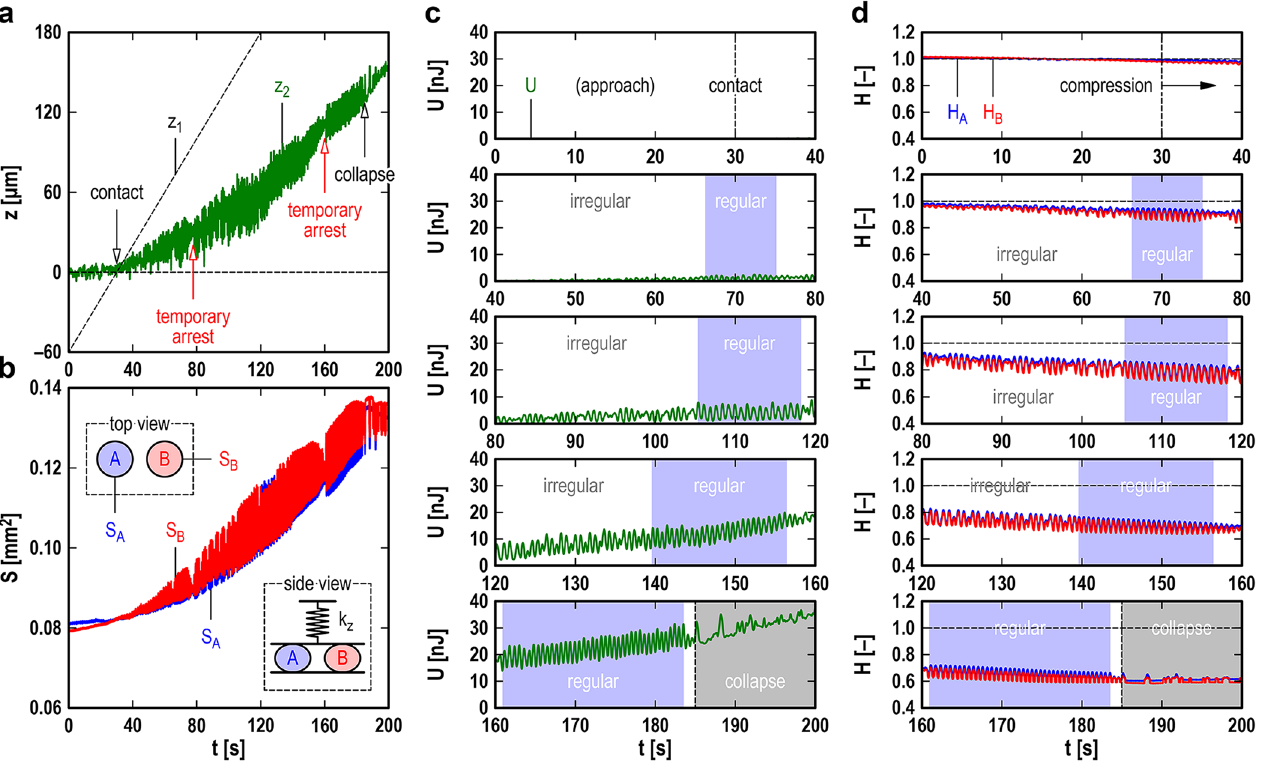
Figure 4. The mechanical response of a pair of cardiac spheroids (CSs) to increasing compression. ( a ) Temporal changes in the vertical position of the lower surface, z 1 (diagonal broken line), and the vertical position of the upper surface, z 2 (green line). ( b ) Temporal changes in the projected areas of the CSs, S A (blue line) and S B (red line), observed by optical microscopy. ( c ) Temporal change in the potential energy of the probe, U = k z z 2 2 /2 (green line). ( d ) Temporal changes in the normalized heights of the CSs, H A = S A0 / S A (blue line) and H B = S B0 / S B (red line), where S A0 and S B0 are the projected areas of the CSs under no compression. The light blue bands in ( c ) and ( d ) represent the periods of regular synchronous beating. Experimental conditions: D A = 322